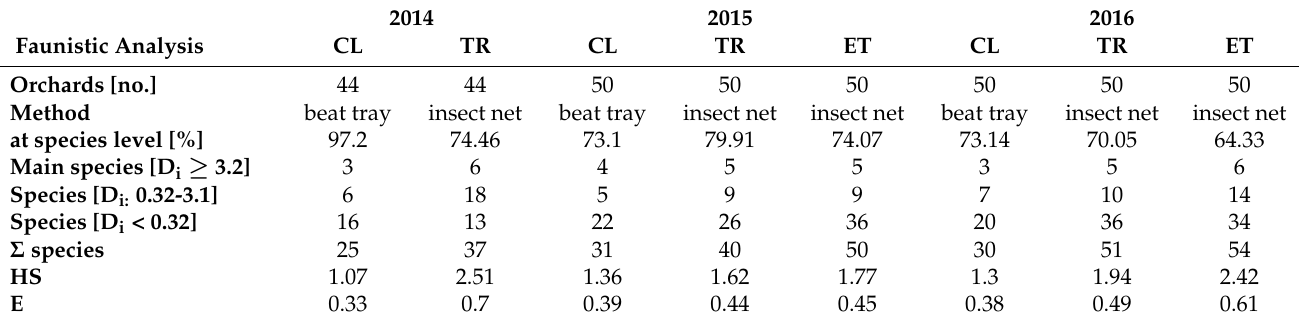
Table 1. Results on the faunistic analysis on the multistrata habitat “apple orchard” for each sampling year and zone from 2014 to 2016. CL = canopy layer; TR = understory vegetation; ET = ecotone; D i = dominance index (%); HS = Shannon-Wiener Index; E = evenness